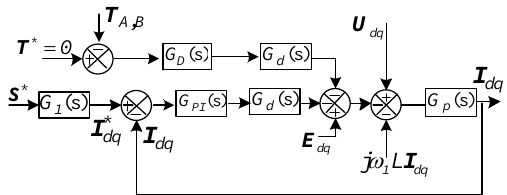
Figure 3. Block diagram of VSC with the proposed control.